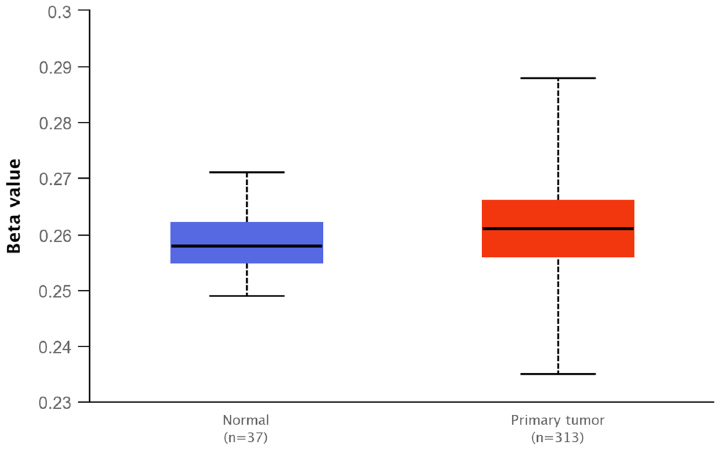
Figure 6. The promoter methylation level of the TGFB1 gene in colon adenocarcinoma tissue in comparison with normal colon tissue by the UALCAN